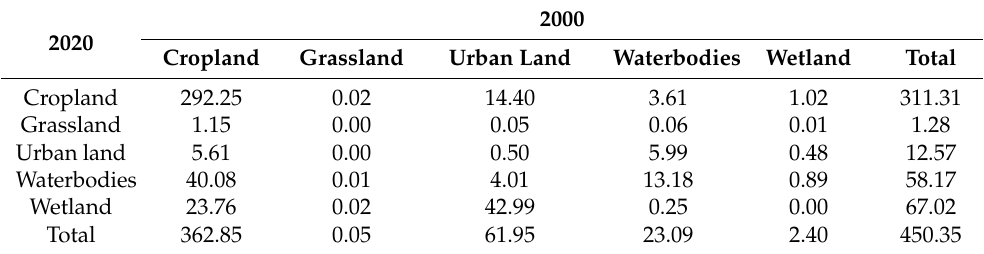
Table 4. Land-use change matrix of mining area (km 2 ).